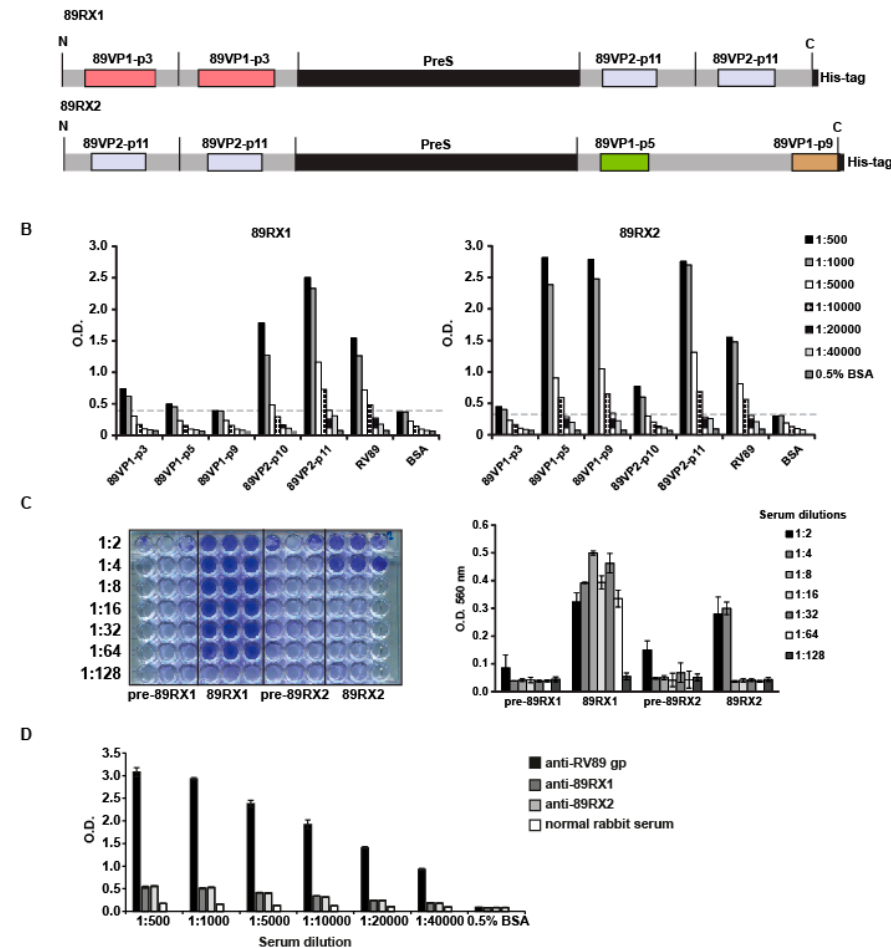
Figure 6. Recombinant PreS-fusion proteins (89RX1, 89RX2) containing VP1- and VP2-derived pep- tides. (A) Scheme of 89RX1 (upper panel) and 89RX2 (lower panel). The PreS carrier protein is col- ored in black and VP1- and VP2-derived peptides are indicated in the same colors as in Figure 5. (B) Reactivity of rabbit anti-RX1 and anti-RX2 IgG antibodies (y-axes: OD values correspond to bound antibodies) to RV89- and RV89-derived antigens and peptides (x-axes). (C) Inhibition of RV89 infec- tion of HeLa cells by serially diluted (1:2 to 1:128) anti-89RX1, anti-89RX2-specific antisera and the corresponding pre-immune sera. The RV89 and medium alone were used as controls. Shown are cells stained with 0.1% crystal violet for viability (left panel) or optical density values (O.D., y-axis), measured after the dissolving of the viability dye (right panel). (D) The RV89-specific IgG reactivity